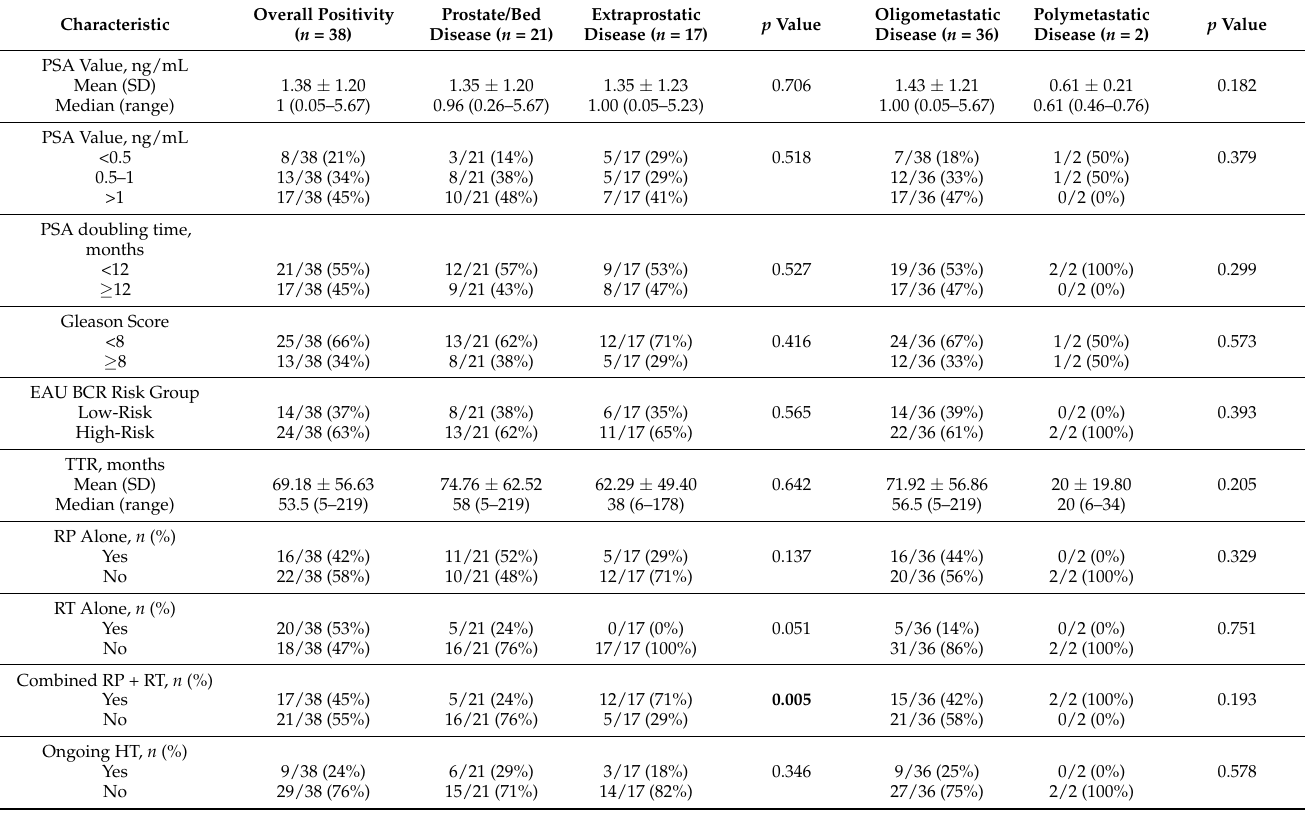
Table 4. Subpopulations analysis in relation to biochemical and clinical–histological